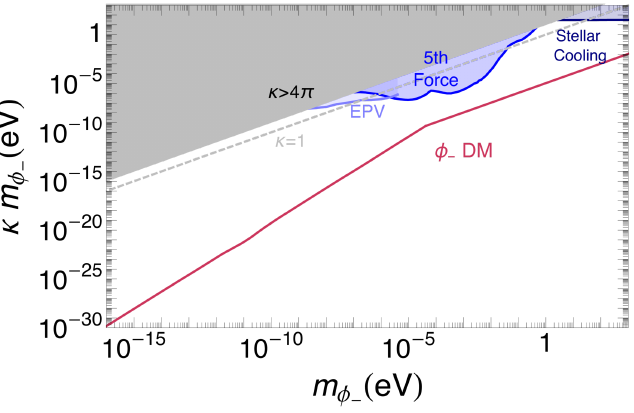
Figure 8 . Laboratory and astrophysical constraints on a scalar coupled to the Higgs boson via the trilinear interaction κm φ φ − | H | 2 . The bounds include tests of the equivalence principle [59–61], − tests of the Newtonian and Casimir potentials (5th force) [62–70] and stellar cooling constraints [71]. The red solid line shows the target given by φ − reproducing the observed dark matter relic density. Above the gray dashed line κ > 1 . In the gray shaded region κ > 4 π , making the scalar potential unnatural. The constraint from AURIGA [72] is not shown because the mass ranged explored is too narrow to be visible on this scale. The bound does not touch our DM parameter space.